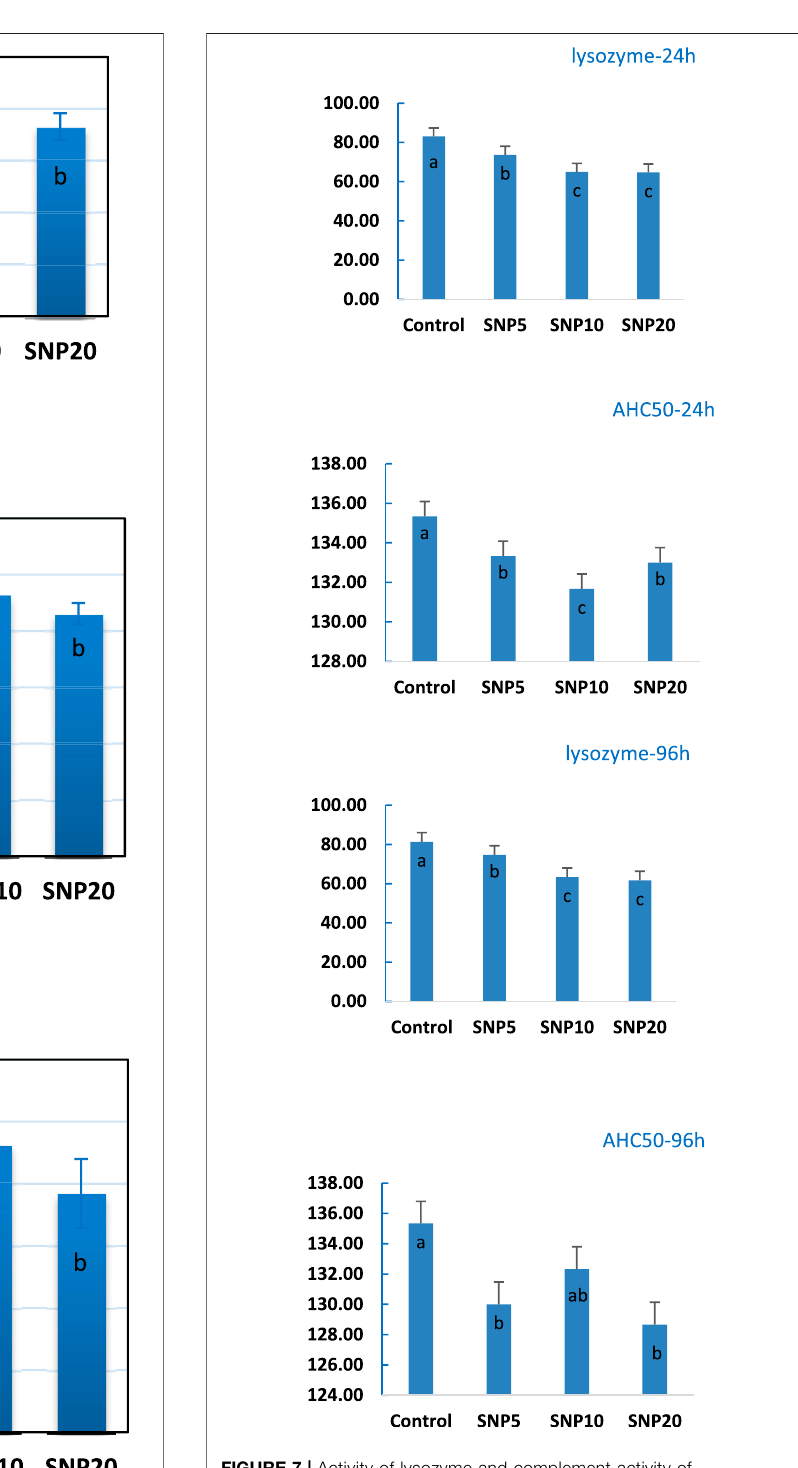
FIGURE 7 | Activity of lysozyme and complement activity of 7 – 8-week-old rats after 96-h gavaging with different levels of silica nanoparticles including zero (as the control), 5 (SiNP5), 10 (SiNP10), and 20 (SiNP20). Different letters indicate signi fi cant differences ( p < 0.05) (A – D)